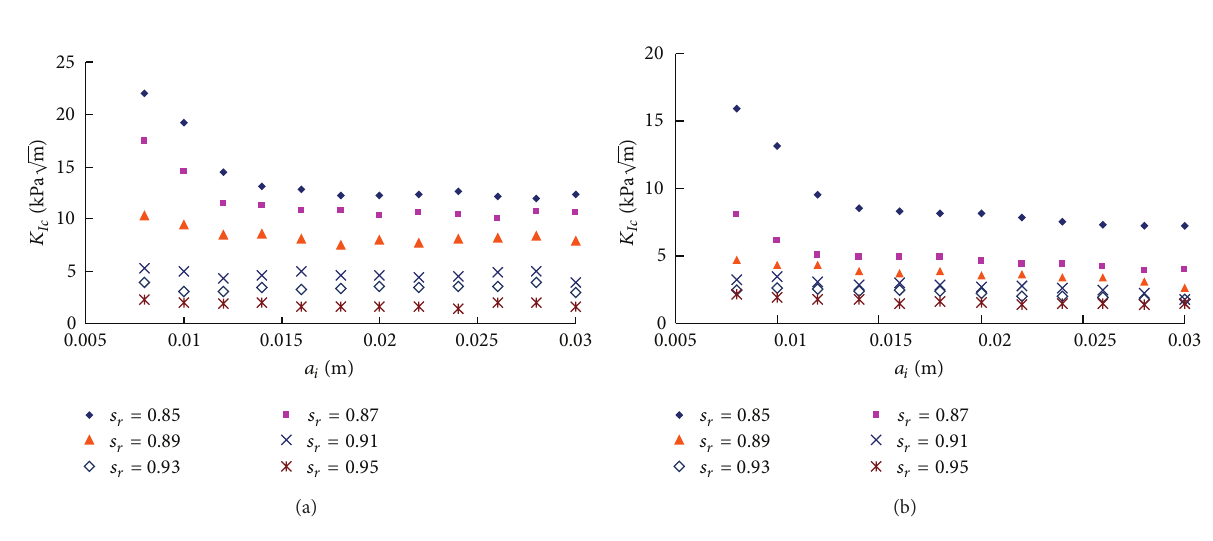
Figure 2: 𝐾 𝐼𝑐 as a function of 𝑠 𝑟 .